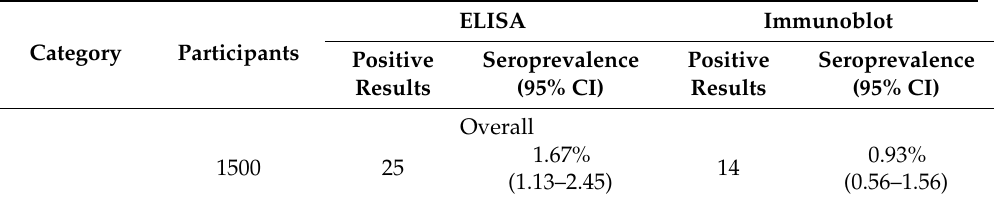
Table 1. Prevalence of anti-SARS-CoV-2 IgG antibodies in Pozna´n metropolitan